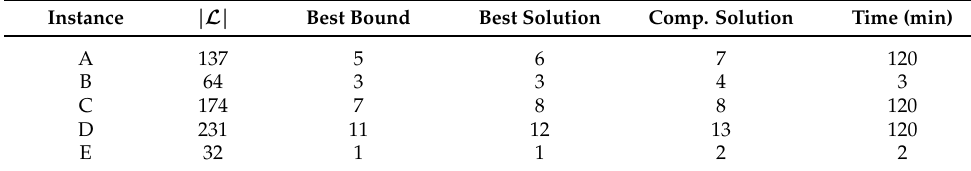
Table 6. Fifth run for all